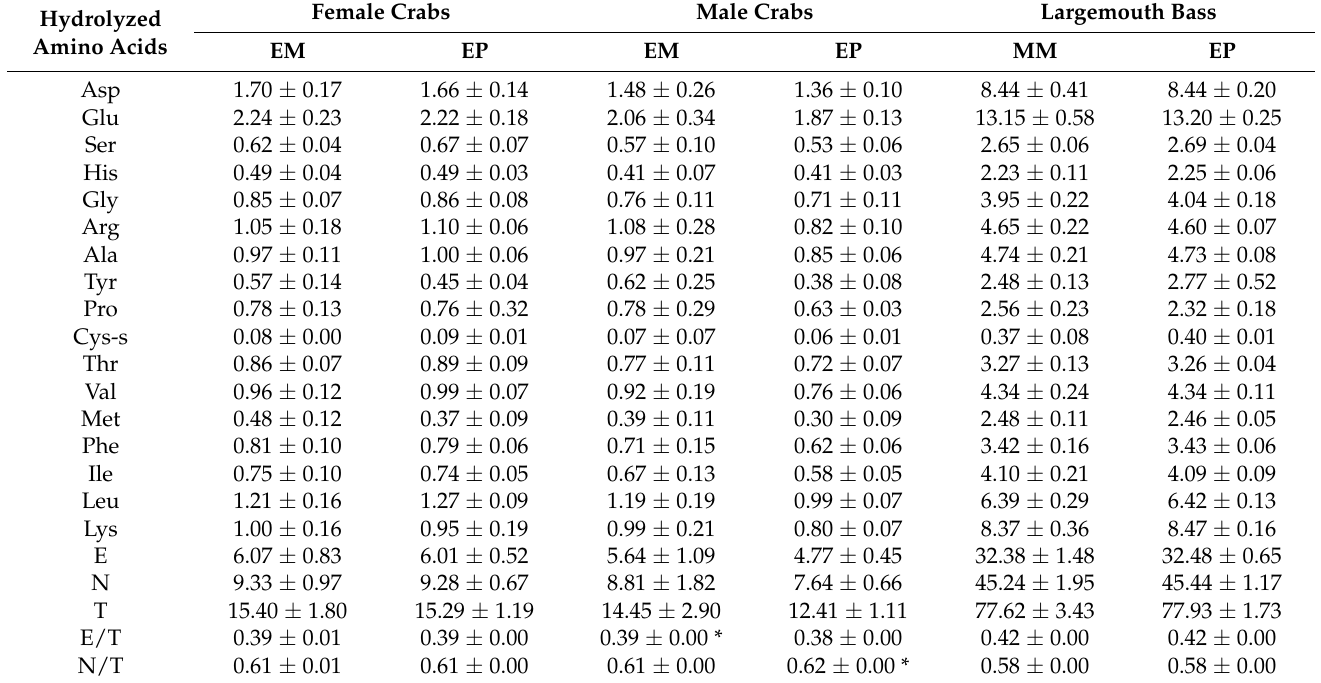
Table 5. Hydrolyzed amino acids (g/100 g tissue) detected in the muscles of Chinese mitten crabs and largemouth bass cultured in the EM, MM, and EP groups. Values are means ± SD ( n = 18).